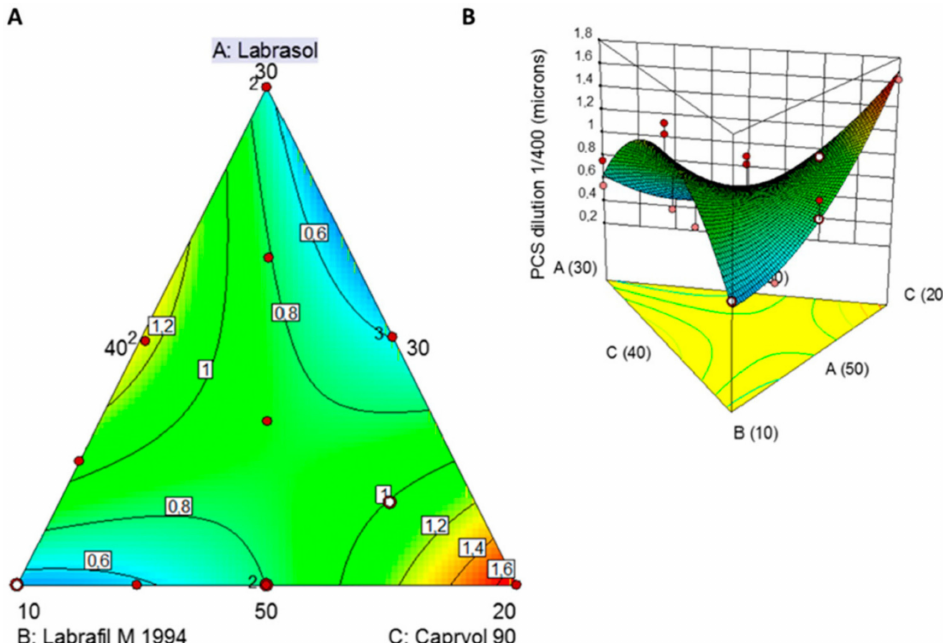
Figure 1. Two dimensions contour plots ( A ) and 3D response surface plot ( B ) showing the influence of Labrasol, Labrafil M 1944, Capryol 90 on the CQAs (particle size (PCS) upon 1 in 400 w / w dilution in de-ionised water (pH 6.5 ± 0.1) of SNEDDS. Red colour indicates larger particle size, while turquoise colour indicates smaller particle size).